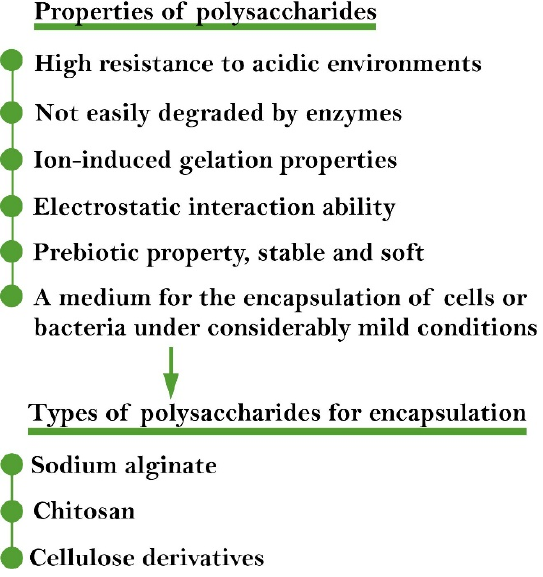
Figure 2. Schematic representation of the mechanism of action of polymer-PGPB soil inoculants for the protection of plants under drought stress.